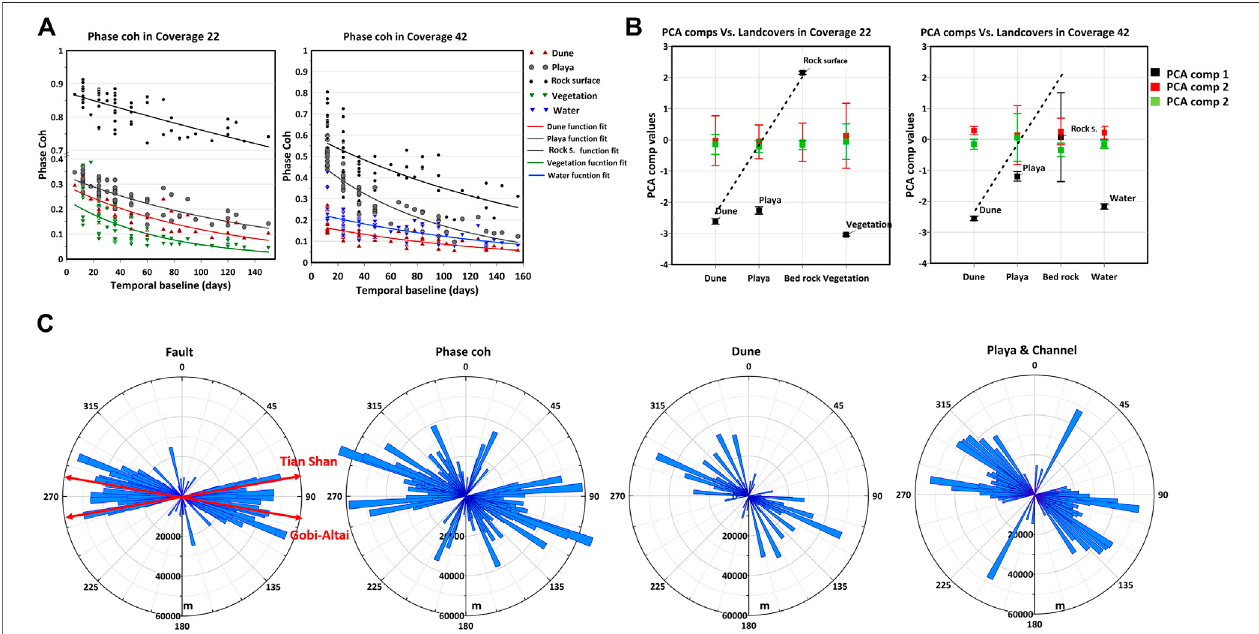
FIGURE 4 | (A) The responses of phase coherences according to temporal baselines and the fi rst PCA components on the different land cover types. Note, the signalsarewellalignedinasinglelinearrelation(dottedline)onthe fi rstPCAandtheirdispersions(errorbarsin (B) )ofthe fi rstPCAareverysmallcomparedtothesecond and thirdPCA components.See Supplementary FigureS2 toidentifythe populations employedin landcover parts. (B) Polarcoordinate representations oflowphase coherences, faults, dune, and dried channels. The polar representation of low phase coherence lines was observed to correspond to the sum of dune and dried channel